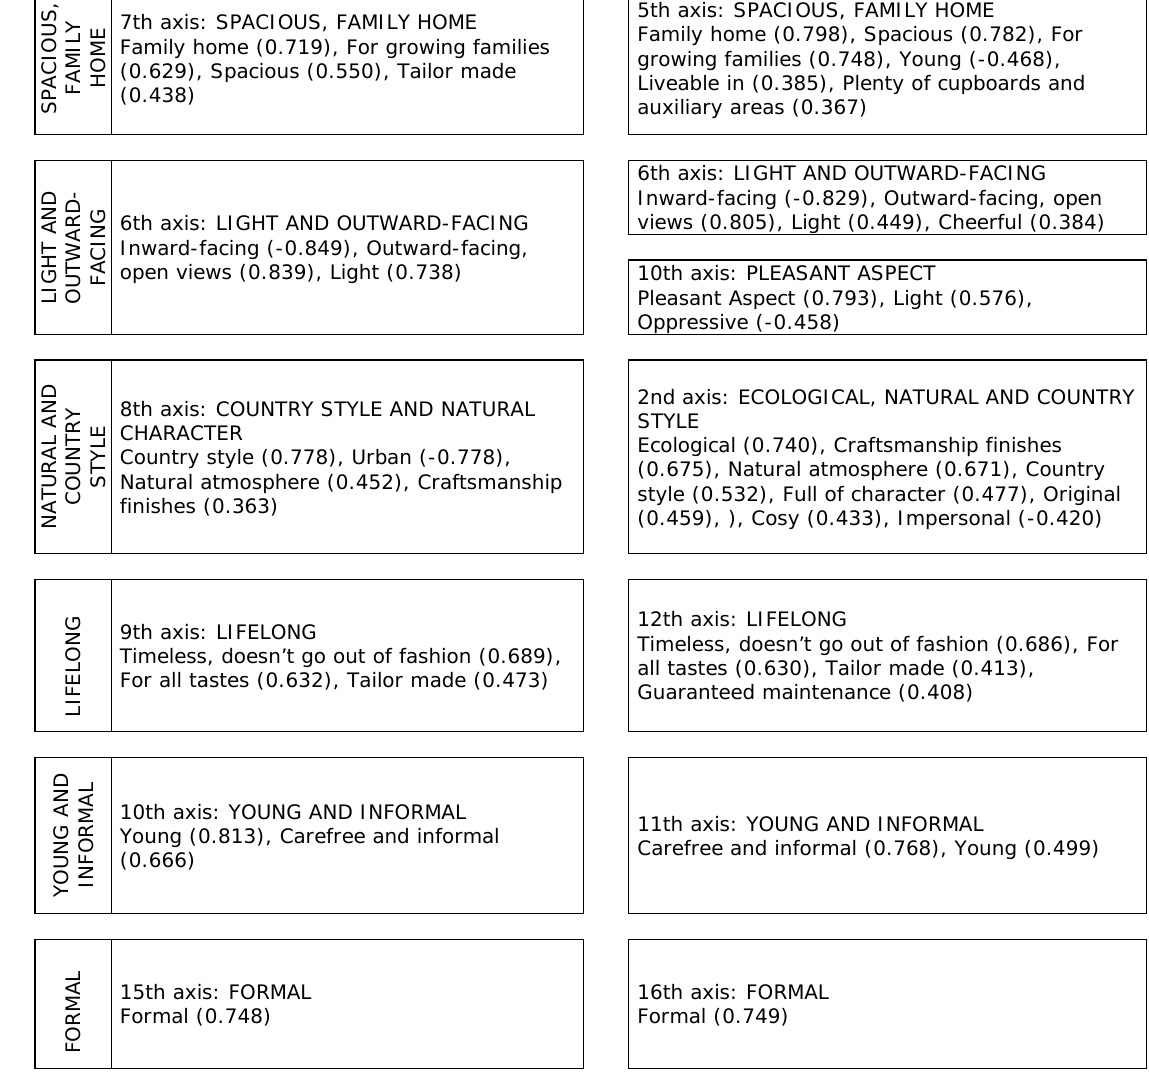
Table 7. “Comparative factors Men-Women”. Source: